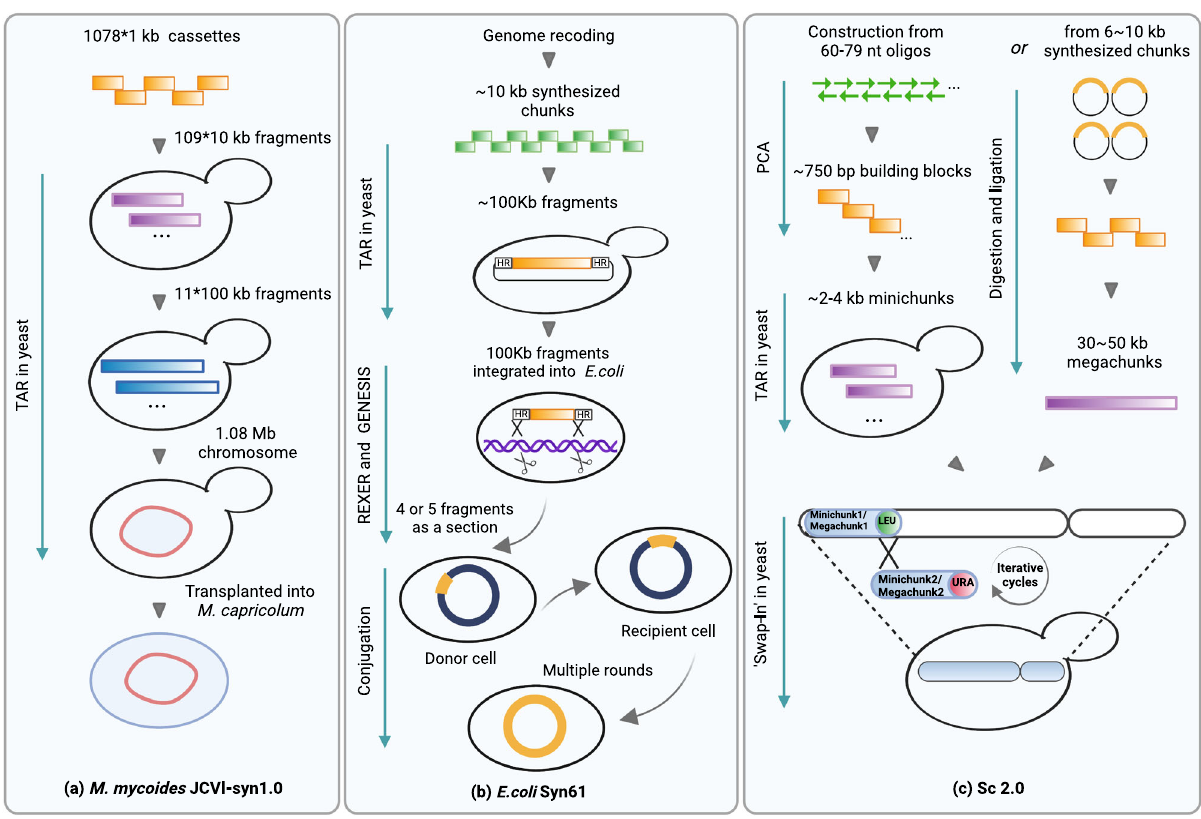
Fig. 2 | Construction of synthetic genomes. Synthetic oligonucleotides are assembled into progressively larger double-stranded DNA fragments using meth- ods such as polymerase cycling assembly (PCA), digestion and ligation, and transformation-associated recombination (TAR) in yeast. a The synthetic Myco- plasma mycoides genome was assembled via TAR in yeast from 1kb DNA cassettes gradually into larger fragments (10kb and 100kb), and fi nally into 1.08Mb gen- ome, prior to extraction and genome transplantation into M. capricolum to gen- erate a new M. mycoides strain controlled by the synthetic genome (JCVI-syn1.0). b Genome-wide recoding was conducted to generate an E. coli strain with 61 codons. The recoded genome was assembled from 10kb fragments into 100kb fragmentsonabacterialarti fi